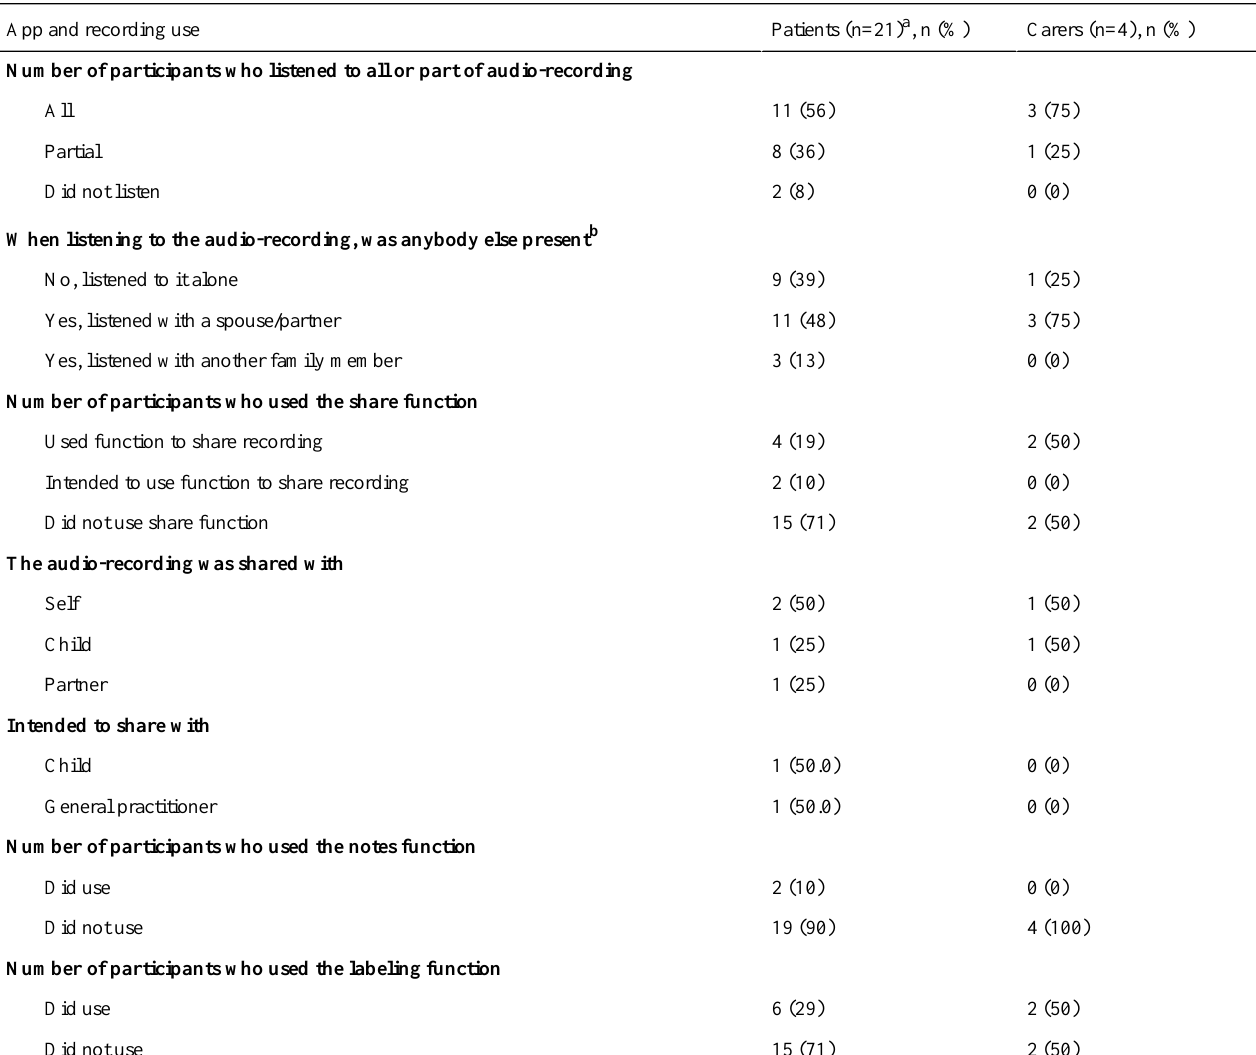
Table 2. Participant and family use of the SecondEars